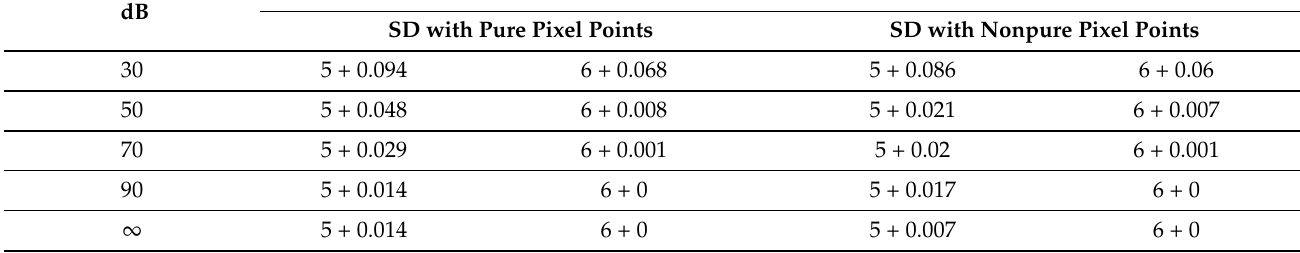
Table 4. The relationship between the number of endmembers and the maximum distance on synthetic data containing pure and nonpure mineral signatures under different noise levels. The two types of synthetic data both have 2000 pixel points and five